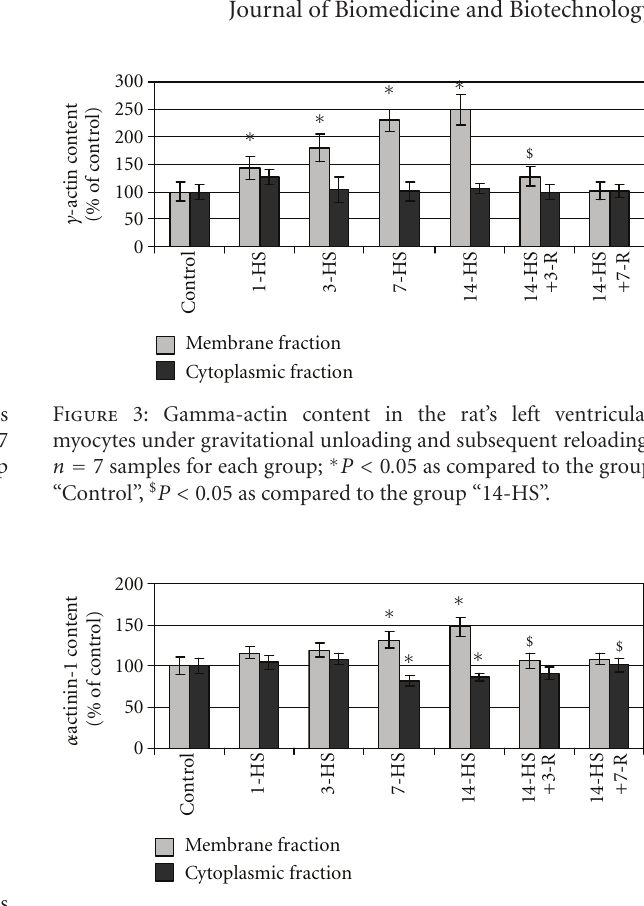
Figure 4: Alpha-actinin-1 content in the rat’s left ventricular myocytes under gravitational unloading and subsequent reloading; n = 7 samples for each group; ∗ P < 0 . 05 as compared to the group “Control”, $ P < 0 . 05 as compared to the group